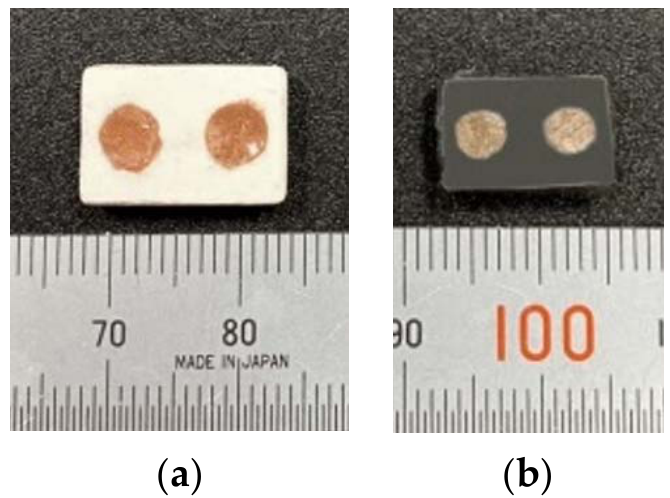
Figure 11. Printed benchmark for a green body ( a ) and a sintered part ( b ).